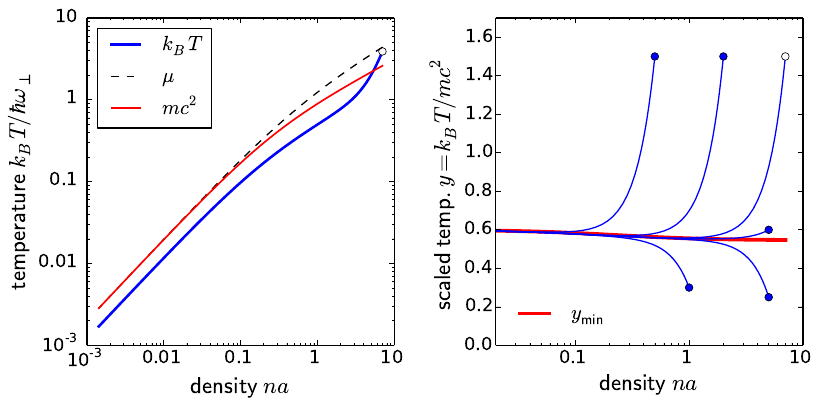
Figure 1: Cooling a quasi-1D gas, homogeneous along the axial direction, by three- body losses. The density is initially so high that transverse broadening is relevant [ the chemical potential does not fulfill µ (cid:28) ħ h ω ⊥ ] . Left: time evolution of the temperature (thick blue), shown versus the time decreasing density. Black dashed and thin red lines show the intrinsic energy scales µ and mc 2 . The system rapidly evolves into a dynamical state where the temperature follows the energy scale mc 2 , rather than T / mc 2 vs. the density. the chemical potential. Right: evolution of the ratio y = k B The curves correspond to different initial values (marked with dots, the white dot corresponding to the parameters on the left). The thick red line shows the function y that gives the positions of lowest values taken by y in the course of cooling. In min this system (homogeneous along the axial direction), all hydrodynamic modes evolve with the same